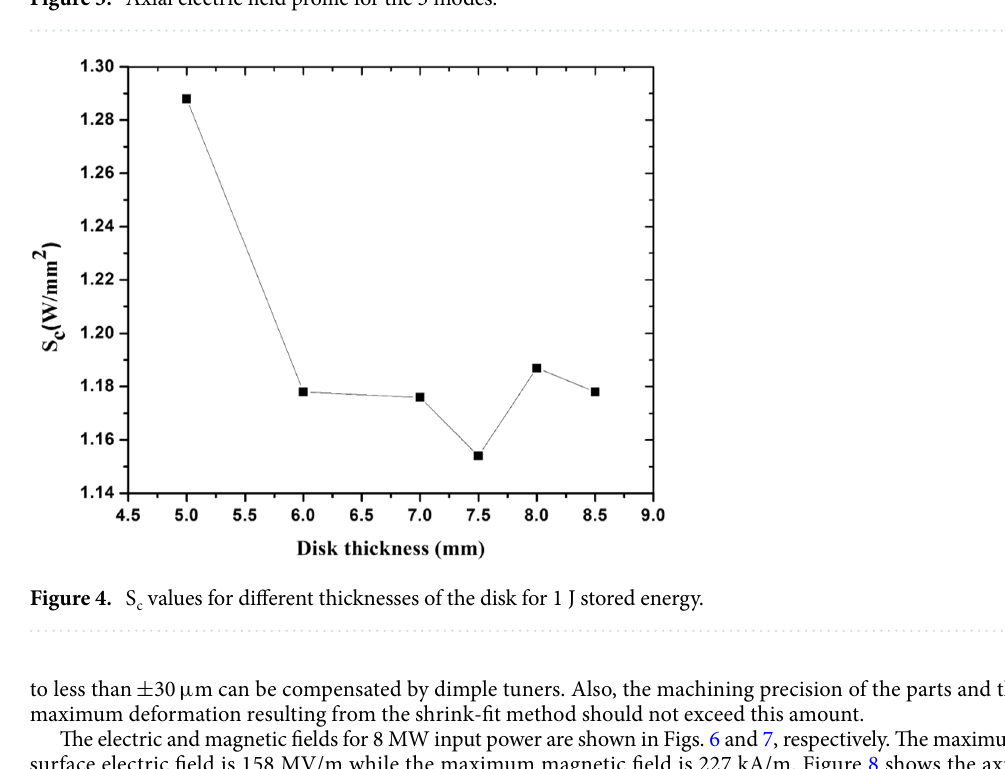
Figure 3. Axial electric field profile for the 3 modes.